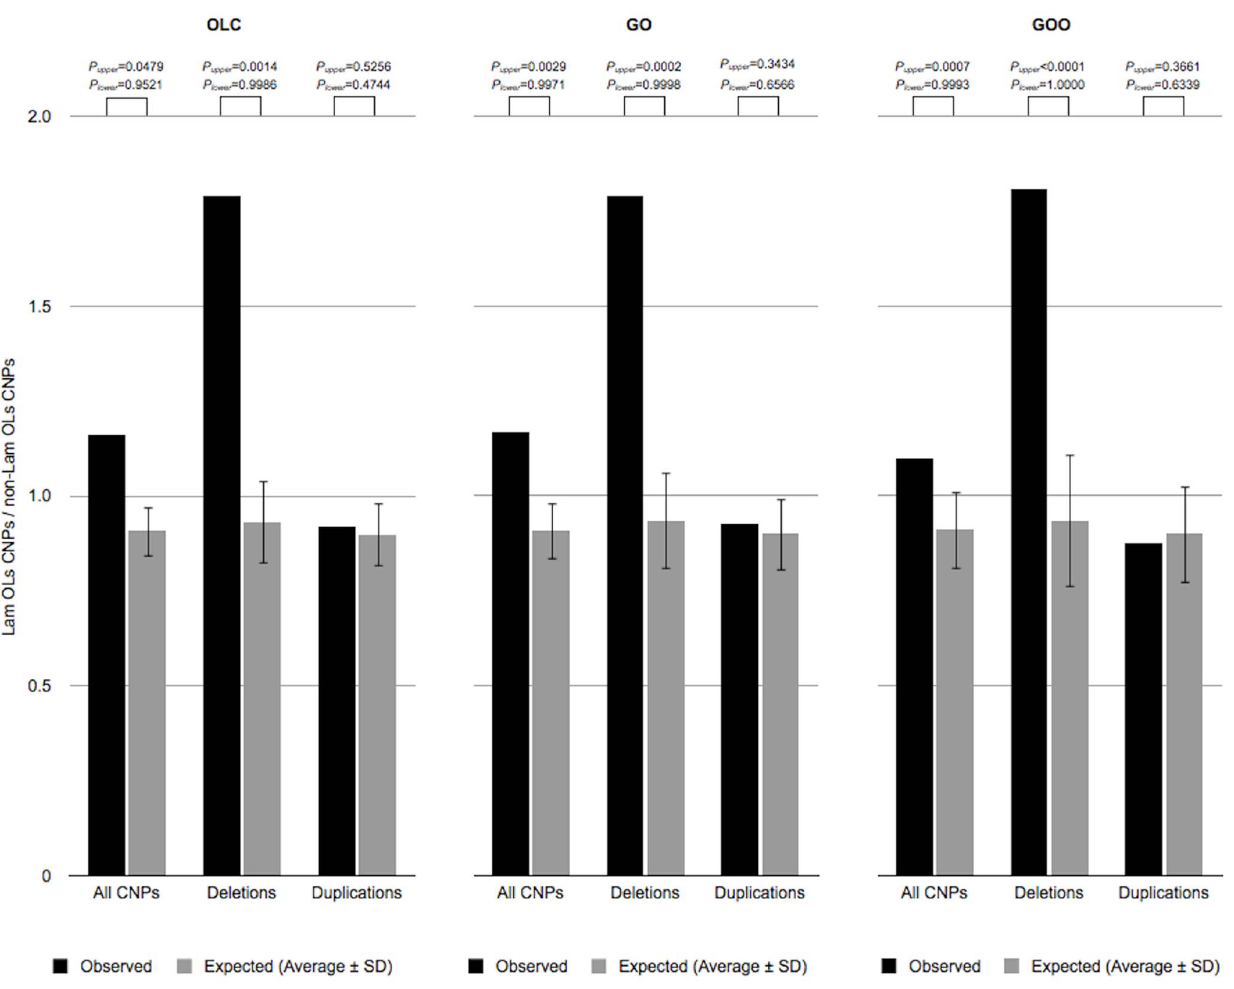
Figure 1. OL distribution of D. melanogaster CNPs. OL distribution of CNPs was studied according to three reconstructions of Drosophila genus gene order evolution: OLC, GO, and GOO (see main text for definitions). Lam OLs were used as proxy for the D. melanogaster peripherome. Expected measures were obtained after assigning new random locations to all CNPs, respecting their chromosome arm distribution (10,000 replicates). P upper and P lower values represent the fraction of random simulations with measures larger or equal, and lower or equal than the observed ones, respectively.